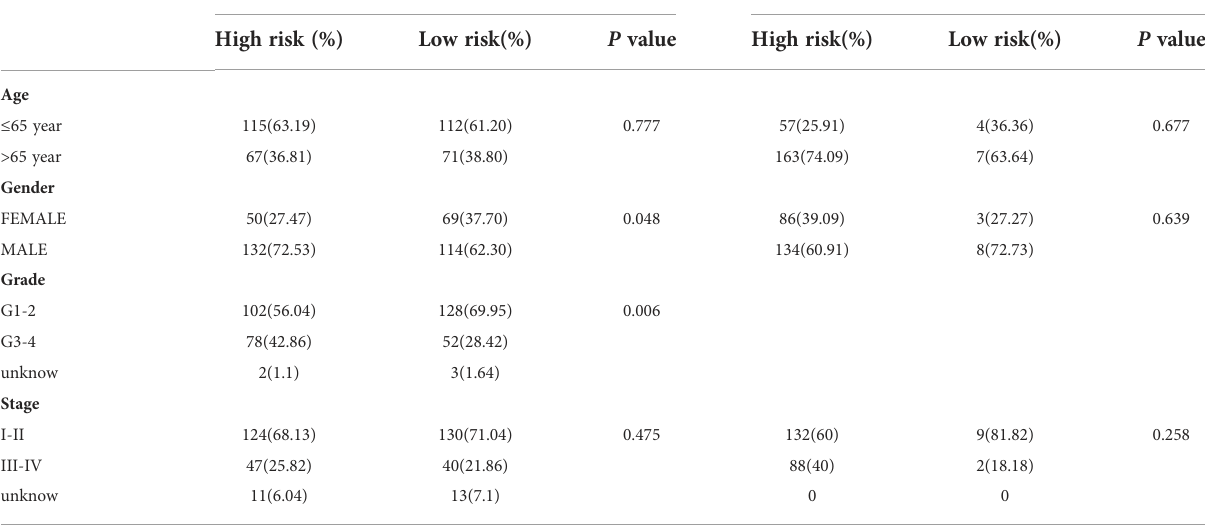
TABLE 1 The association of clinicopathological